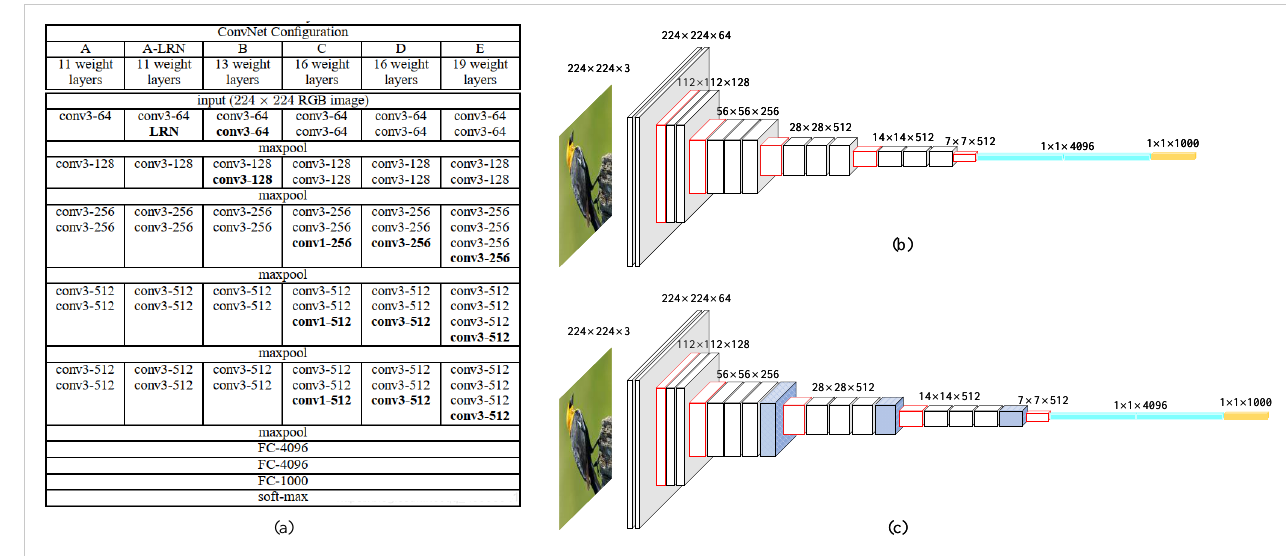
Figure 4. The structure of VGG. ( a ) The structure of VGG, ( b ) The structure of VGG16, ( c ) The structure of